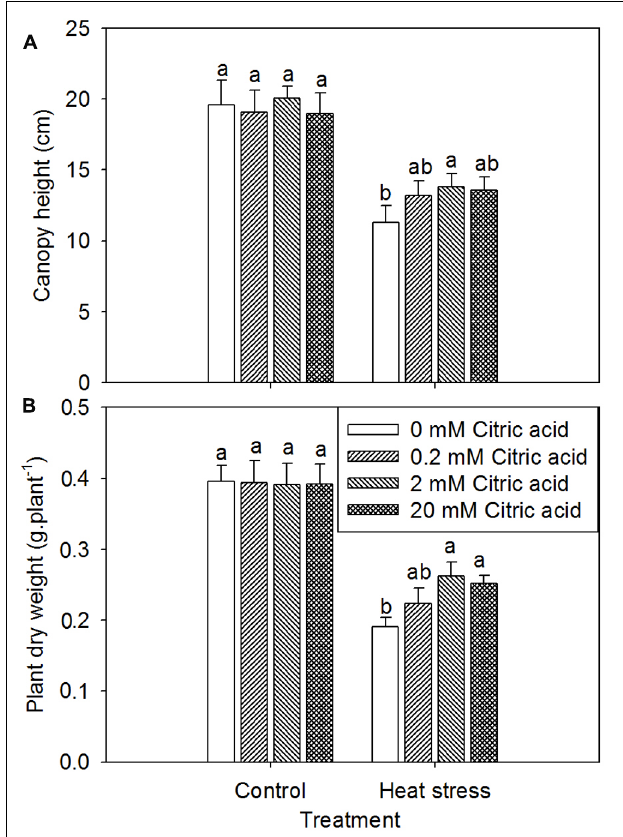
FIGURE 2 | Effect of exogenous citric acid on canopy height (A) and plant dry weight (B) under control (25/20 ± 0.5 ◦ C, day/night) and heat stressed (35/30 ± 0.5 ◦ C, day/night) conditions in tall fescue. Vertical bars on the top provide the standard deviation ( n = 4), and bars with the same letter indicate no significant difference at P < 0.05 for the comparison of different citric acid concentrations under control or heat stress.